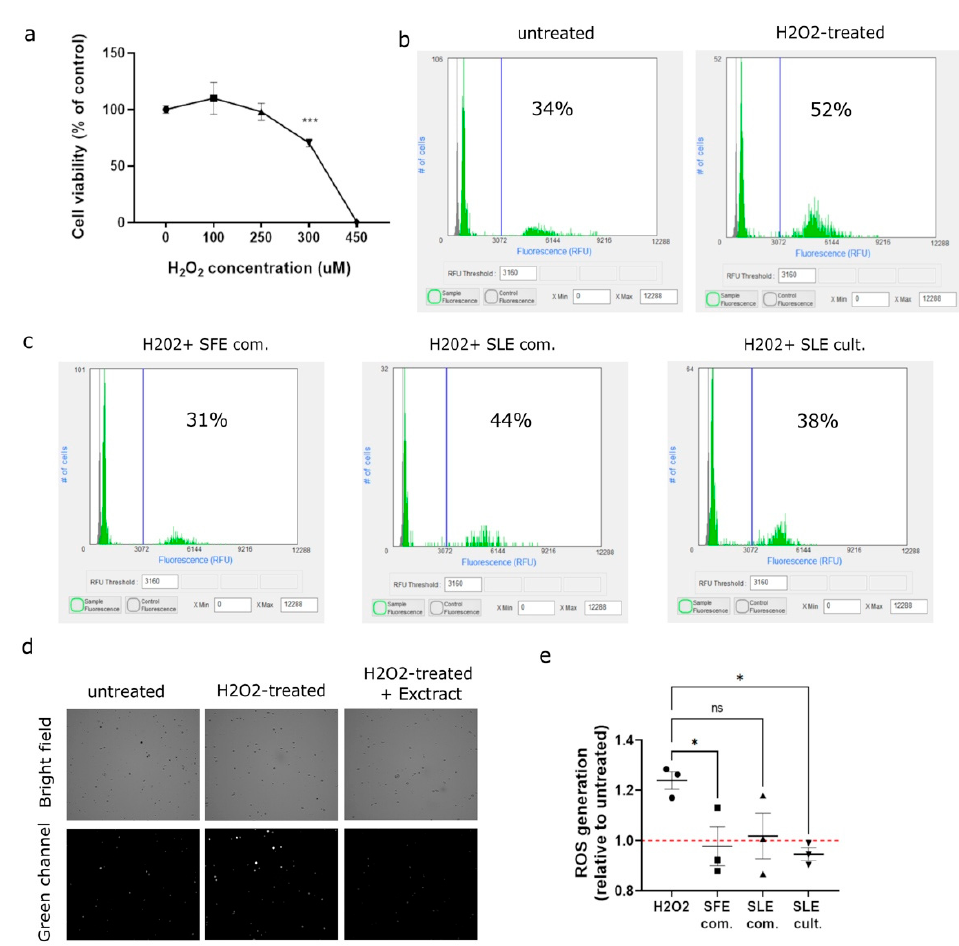
Figure 3. C. vulgaris extracts mediate the inhibition of H 2 O 2 -induced ROS generation in MSCs. ( a ) Killing curve of MSCs treated with increasing concentrations of H 2 O 2 for 24 h. Data represent mean ± SEM (Comparisons by ANOVA with Dunnett’s multiple comparisons test, *** p < 0.001, n = 3 independent experiments); ( b ) representative histograms of DCF-DA fluorescence of H 2 O 2 -treated cells and control untreated cells. Numbers in the histograms represent the percentage (%) of cells with fluorescence intensity above the threshold as determined by the background noise from unstained cells, scoring positive for green signal; ( c ) representative histograms of DCF-DA fluorescence of H 2 O 2 -treated MSCs when pre-incubated with C. vulgaris extracts. Numbers in the histograms represent the percentage (%) of cells scoring positive for green signal (similarly as in ( b )). ( d ) representative bright field and green fluorescence images of MSCs recorded from the automated fluorescent cell counter from three different conditions: untreated cells ( left ), H 2 O 2 -treated ( middle ), extract+H 2 O 2 -treated ( right ); ( e ) quantification of reactive oxygen species (ROS) generation in H 2 O 2 -treated MSCs when pre-incubated with C. vulgaris extracts. Quantification of fluorescence intensity was performed relative to untreated cells. Data represent mean ± SEM (Comparisons by ANOVA with Dunnett’s multiple comparisons test, * p < 0.05, n = 3 independent experiments, ns = non-significant).